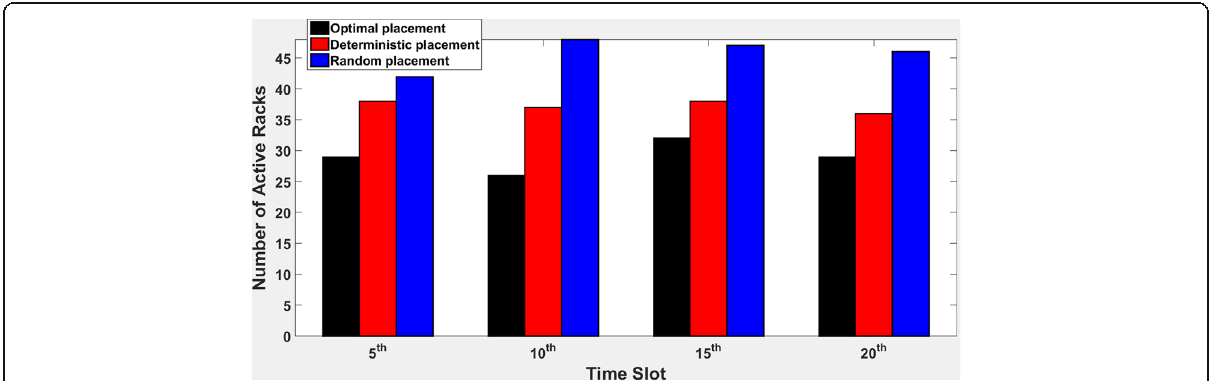
Fig. 11 The number of active racks in the system at slots 5, 10, 15 and 20 for optimal with migration cost (Gr = 0.3), deterministic and random placement of